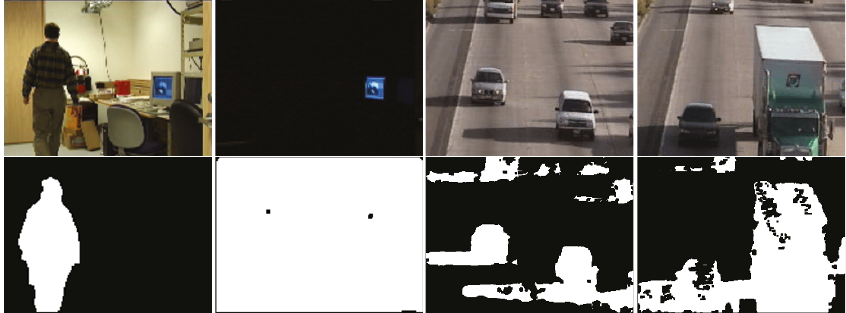
Figure 12: Some failed detection results by our method. The first row contains the original video frames. The second row contains the corresponding detection results. Challenges in the first two and the rest columns are light switch and cast shadow. The two image sequences are from [32, 33],